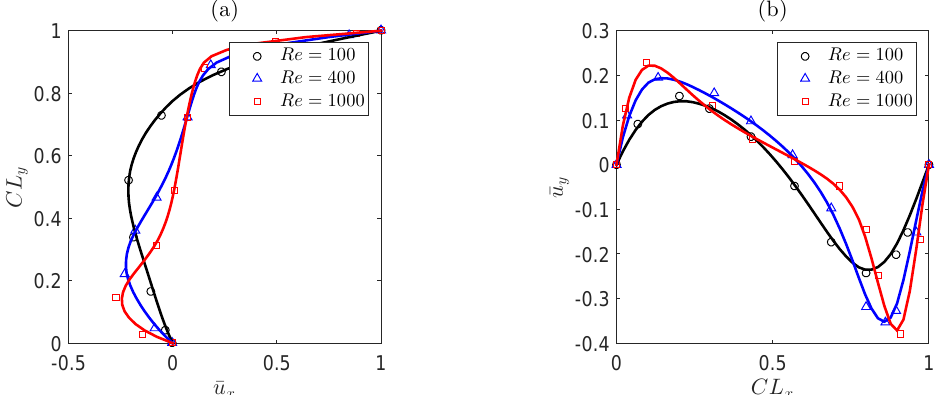
Figure 5. Normalised velocity profiles ( a ) u at CL y , and ( b ) v at CL x , discrete points from